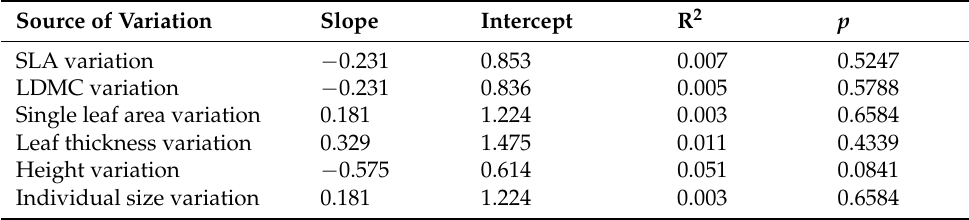
Figure 5. Relationships of abundance with trait mean of SLA ( a ), LDMC ( b ), single leaf area ( c ), leaf thickness ( d ), height ( e ) and individual size ( f ). Table 4. Regression analysis of the variation of different traits with plant